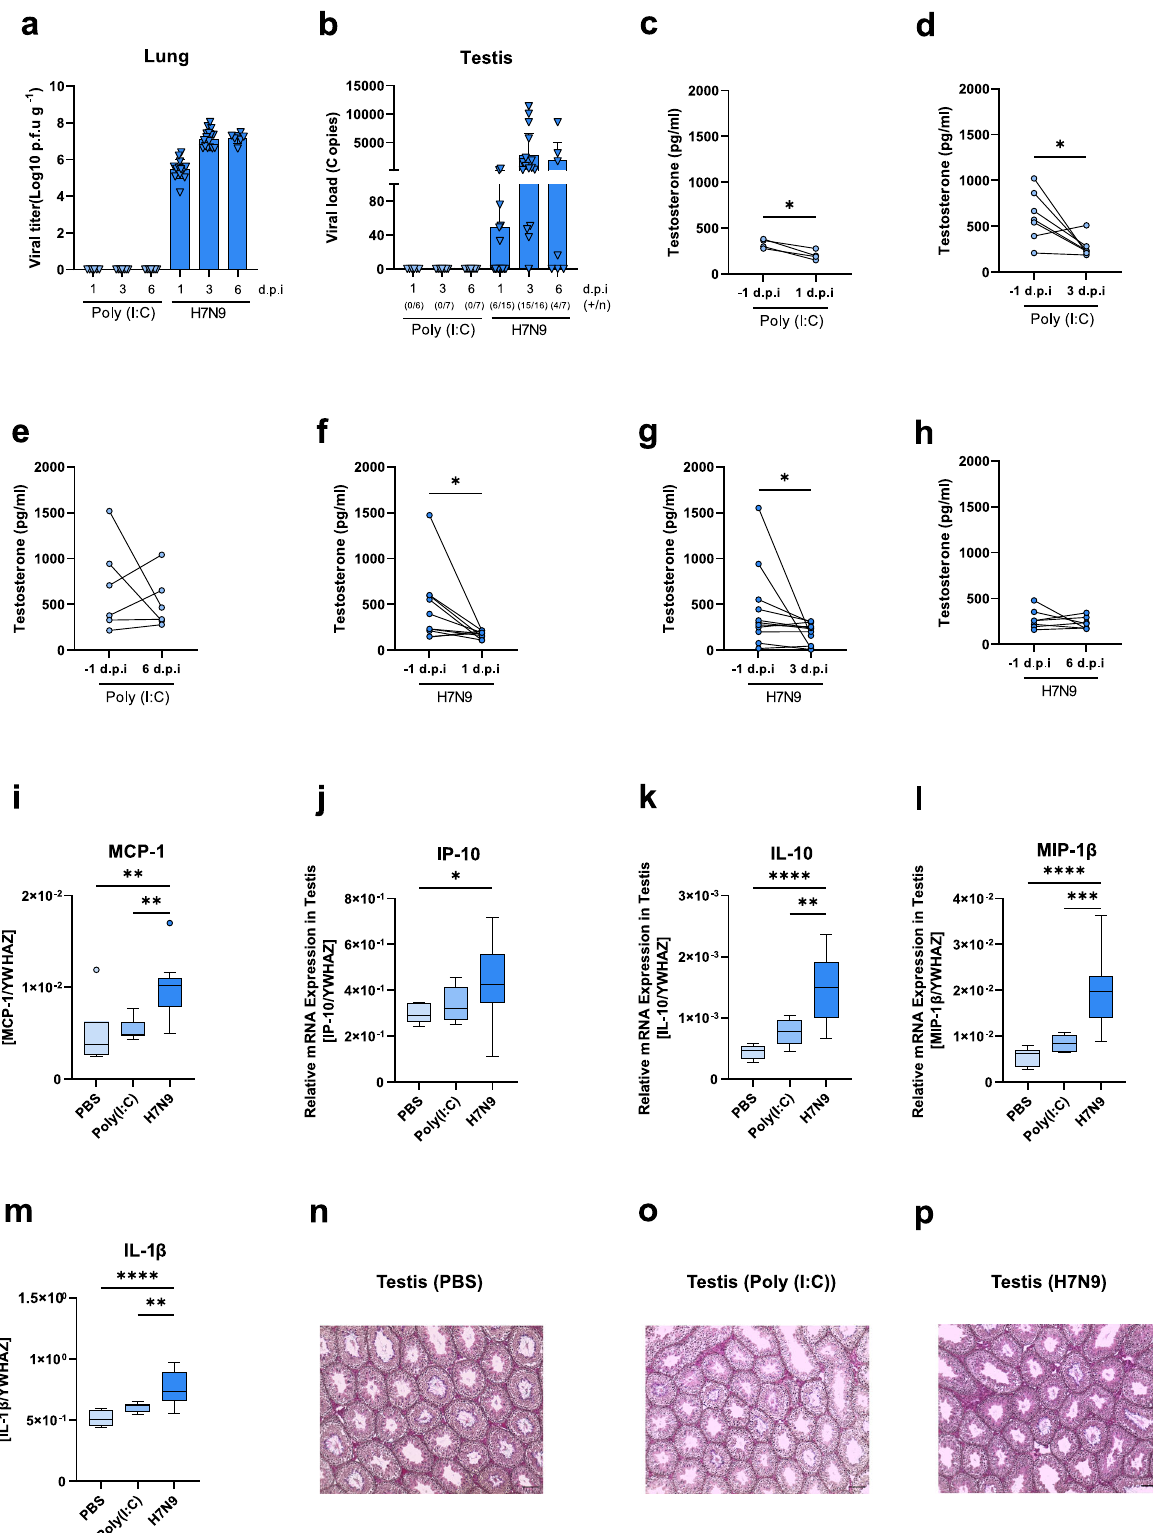
the RNase-free DNase Set (QIAGEN). cDNA was generated using